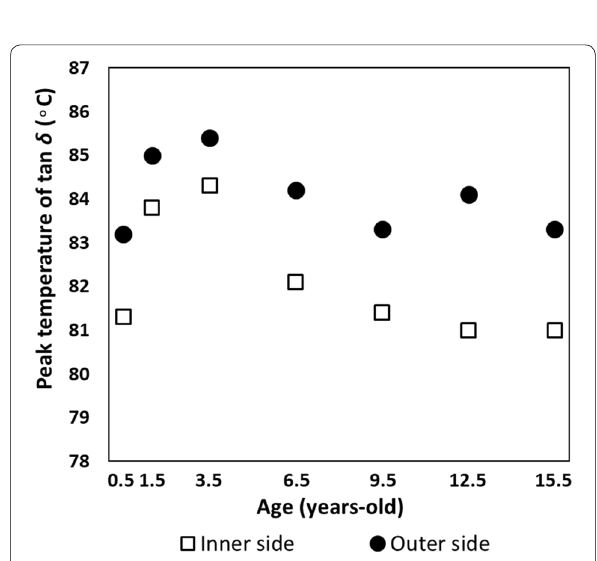
Fig. 4 Peak temperature tan δ value of bamboo samples at 0.05 Hz